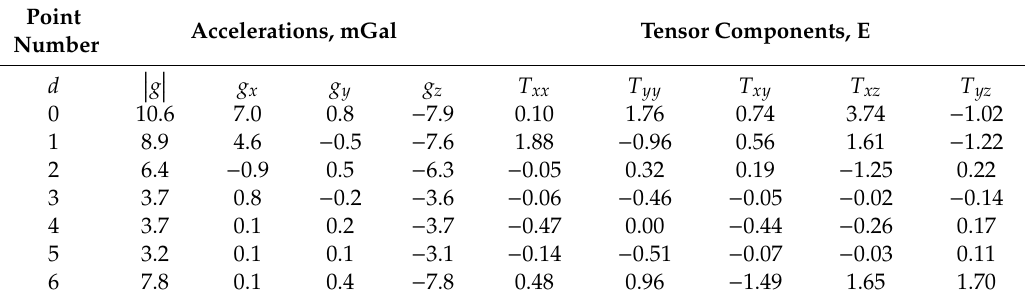
Table 3. Route points characteristics for the region with low-amplitude anomalies.